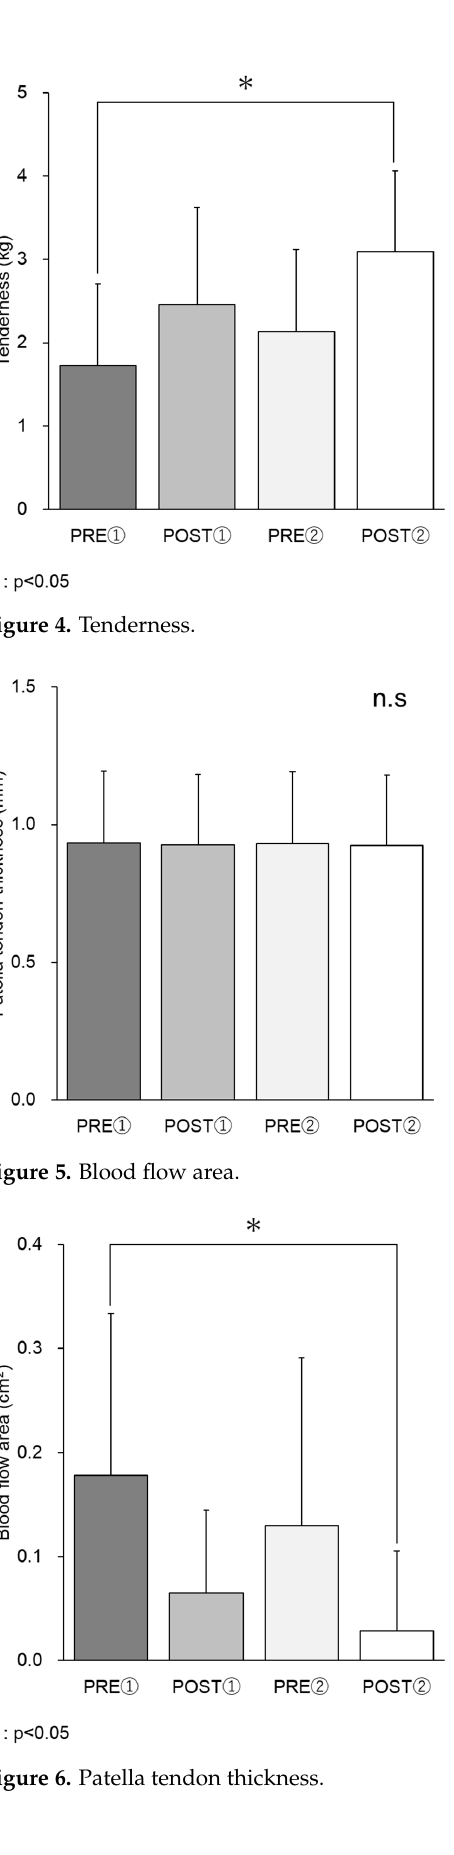
Figure 3. Numeric Rating Scale.